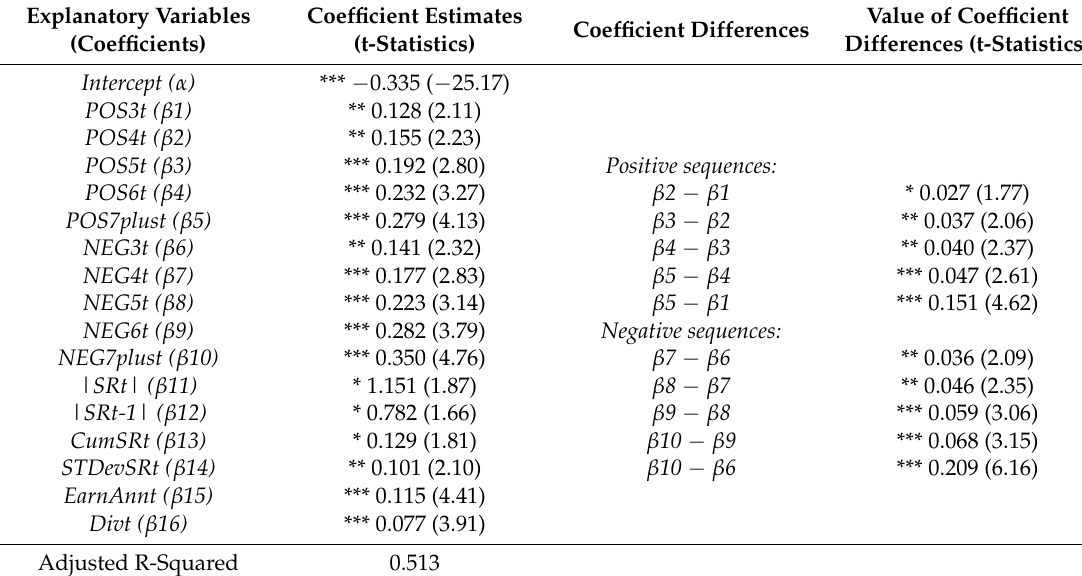
Table 5. Multifactor regression analysis (regression (5)): Return sequence effect on stock trading volumes (Dependent